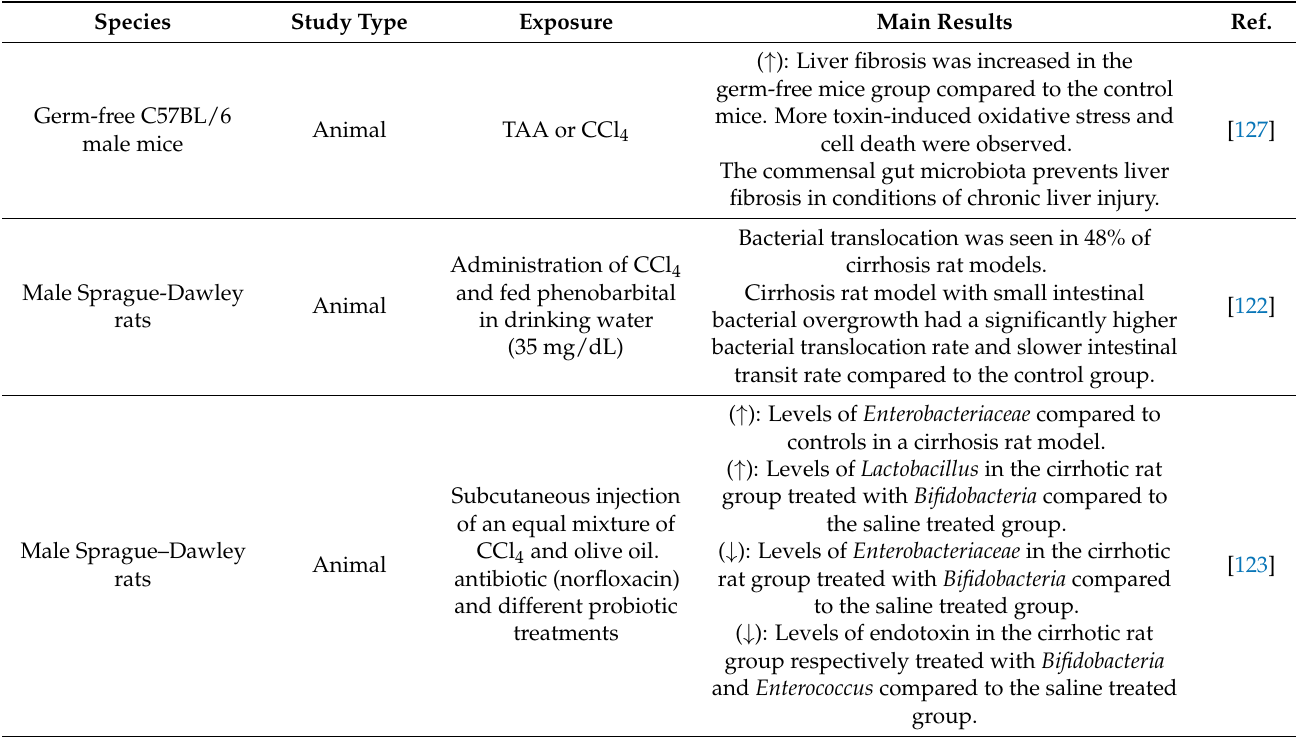
Table 3. Liver cirrhosis studies related to the immune